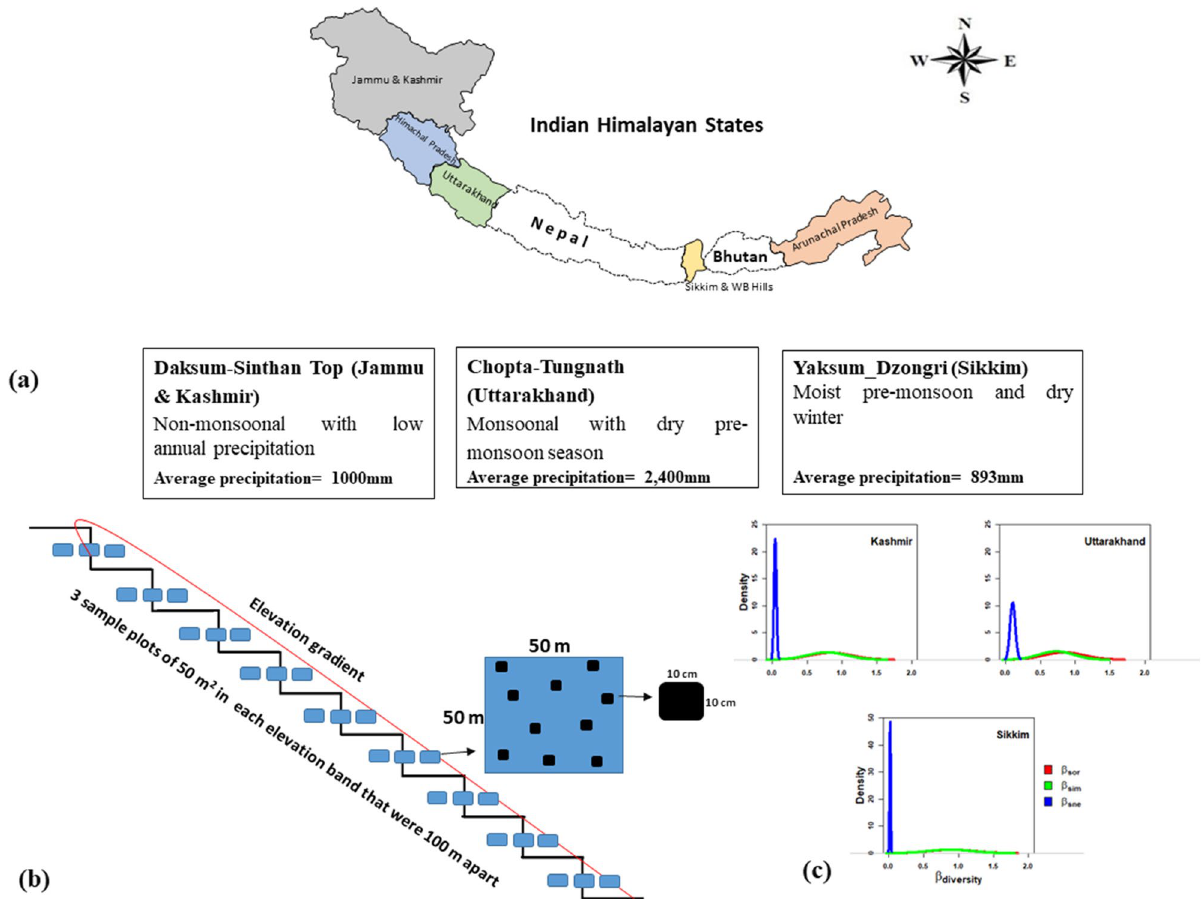
based on pairs from one elevation band to the next neighbouring elevation band were also computed ( c